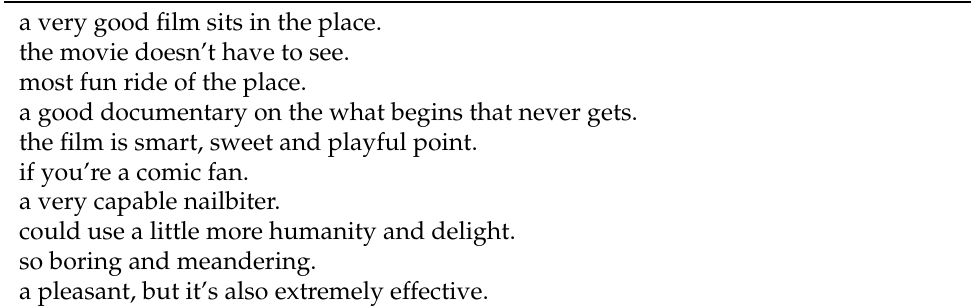
Table A4. The data samples generated from the Movie Reviews